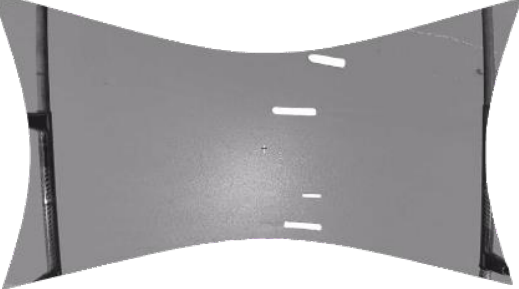
Figure 7. The target detection of the vessel.